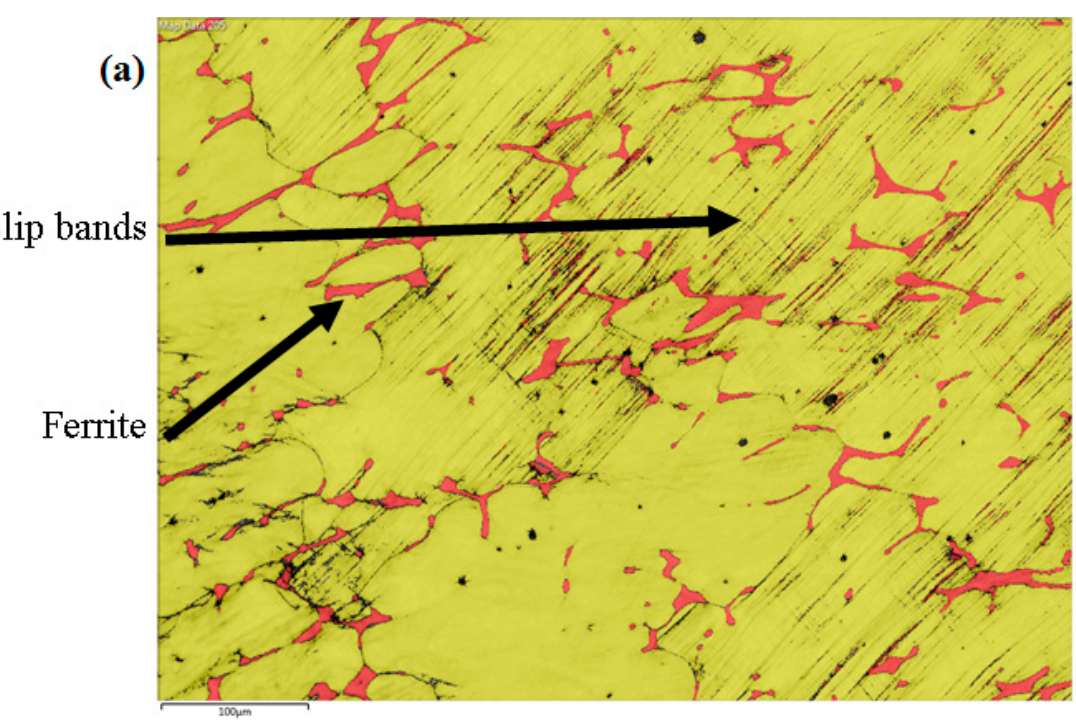
Figure 8. Variations of HRB hardness measurement with aging time.